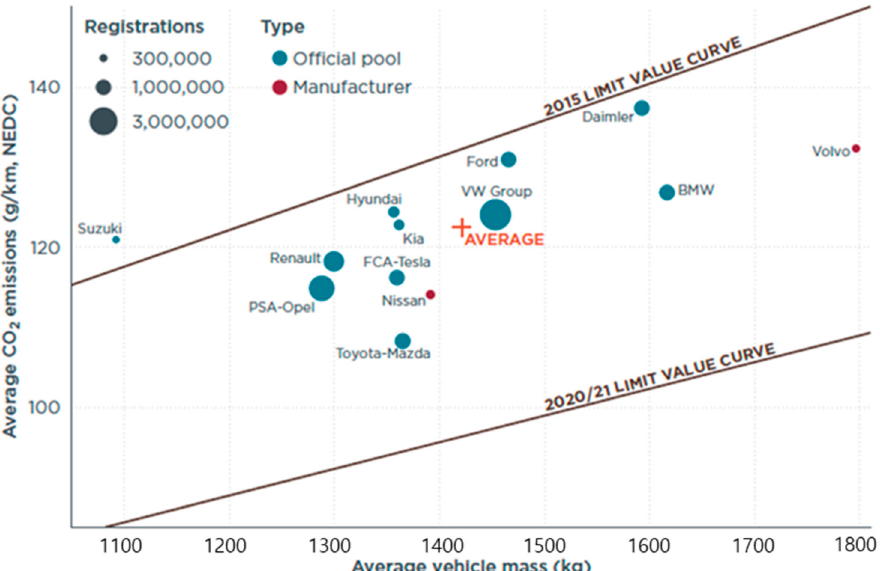
Figure 1. Performance of top-selling EU passenger car manufacturers in 2019 compared to 2015, and the 2020/2021 emissions target compliance curves.